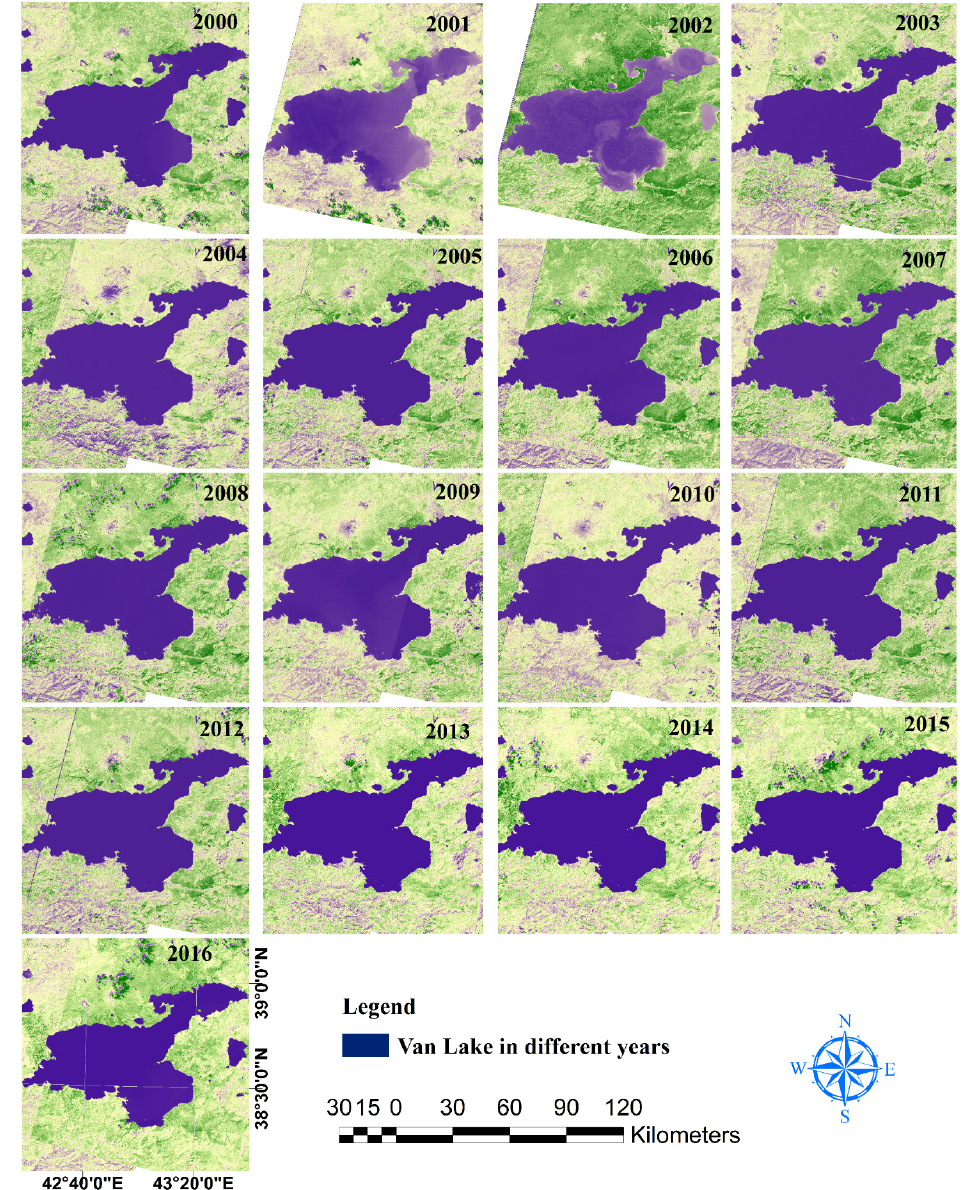
Figure 7. Maps illustrating surface area changes in LV as extracted from Landsat satellite images.